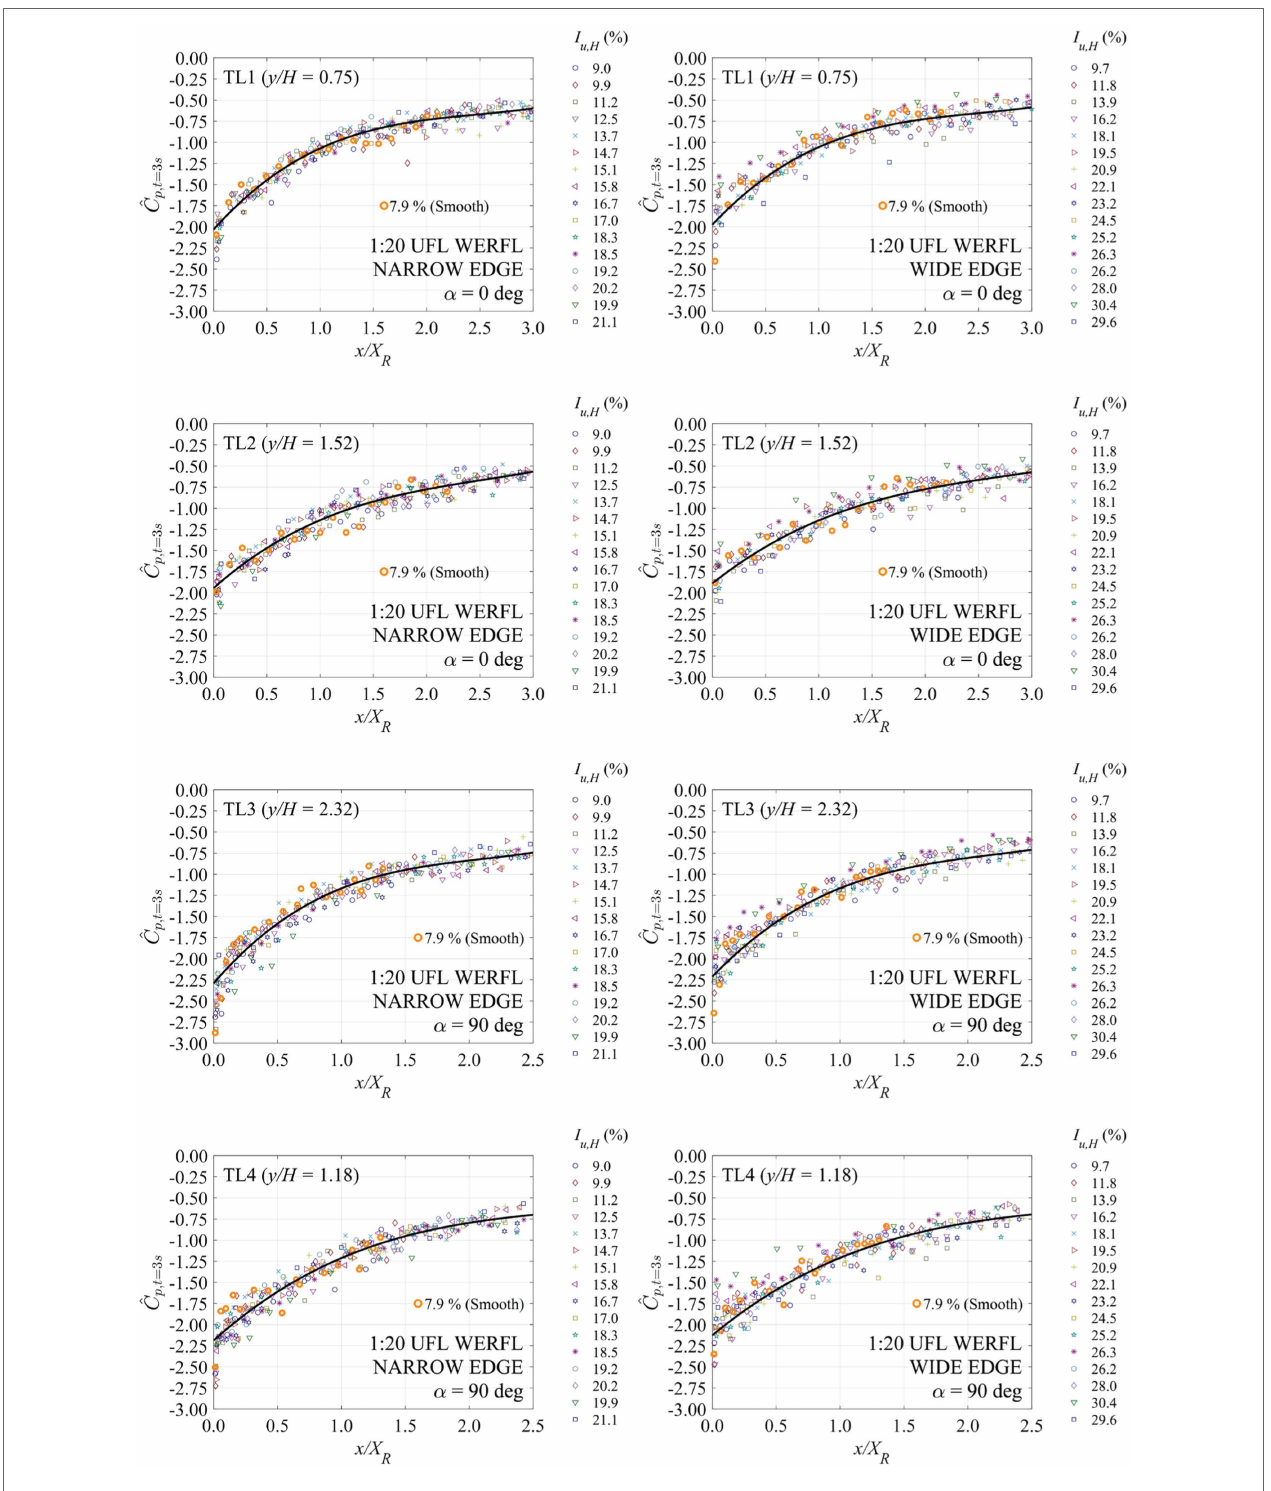
FIGURE 14 | Peak pressure coefficient transects for the narrow (left column) and wide (right column) roughness element orientations normalized by the gust velocity pressure at eave height using a non-Gaussian peak factor model (Kareem and Zhao, 1994).